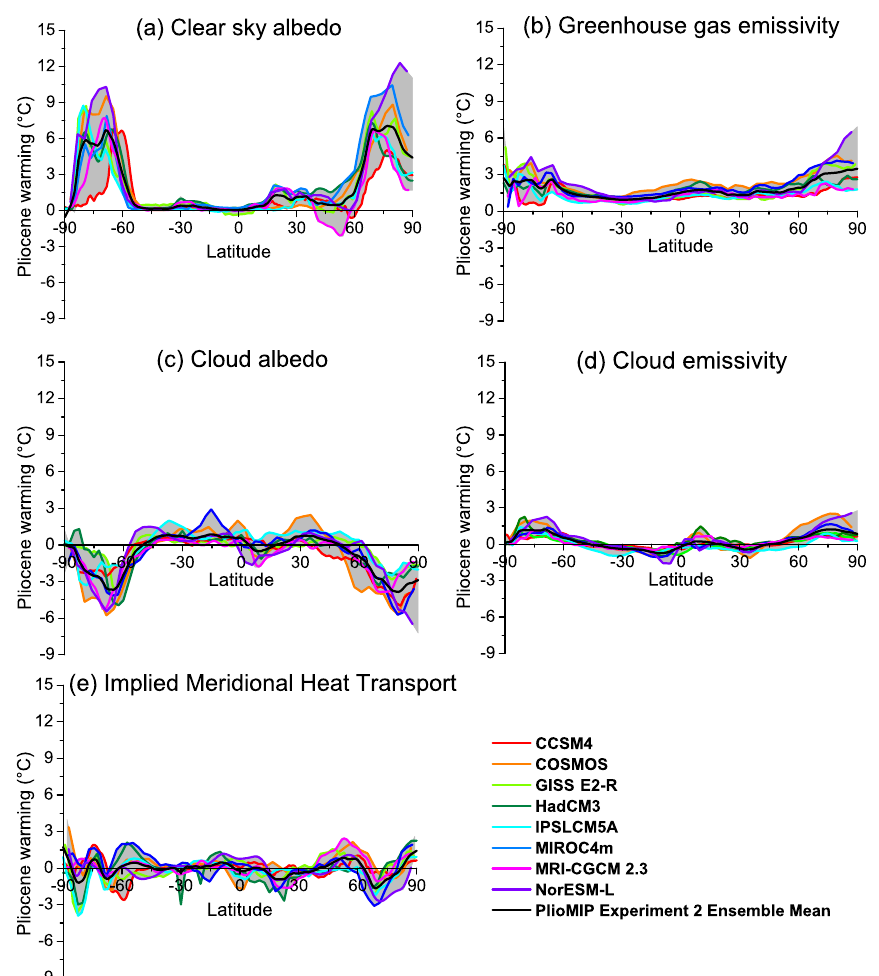
Fig. 5. Breakdown of the energy balance components, (a) clear sky albedo, (b) greenhouse gas emissivity, (c) cloud albedo, (d) cloud emissivity and (e) implied meridional heat transport. Solid black line shows the multi-model mean, range is shown by the grey shading and each of the individual model results is shown by the coloured solid